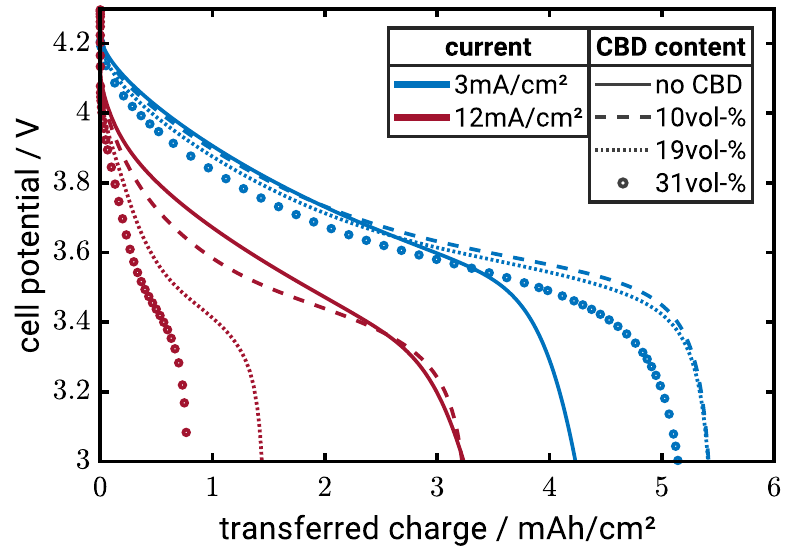
Figure 6. Discharge simulations for electrode with 60 vol-% CAM ( d 50 = 10µm) and current densities of 3 mA/cm 2 (blue lines) and 12 mA/cm 2 (red lines). The line style represents different CBD contents.